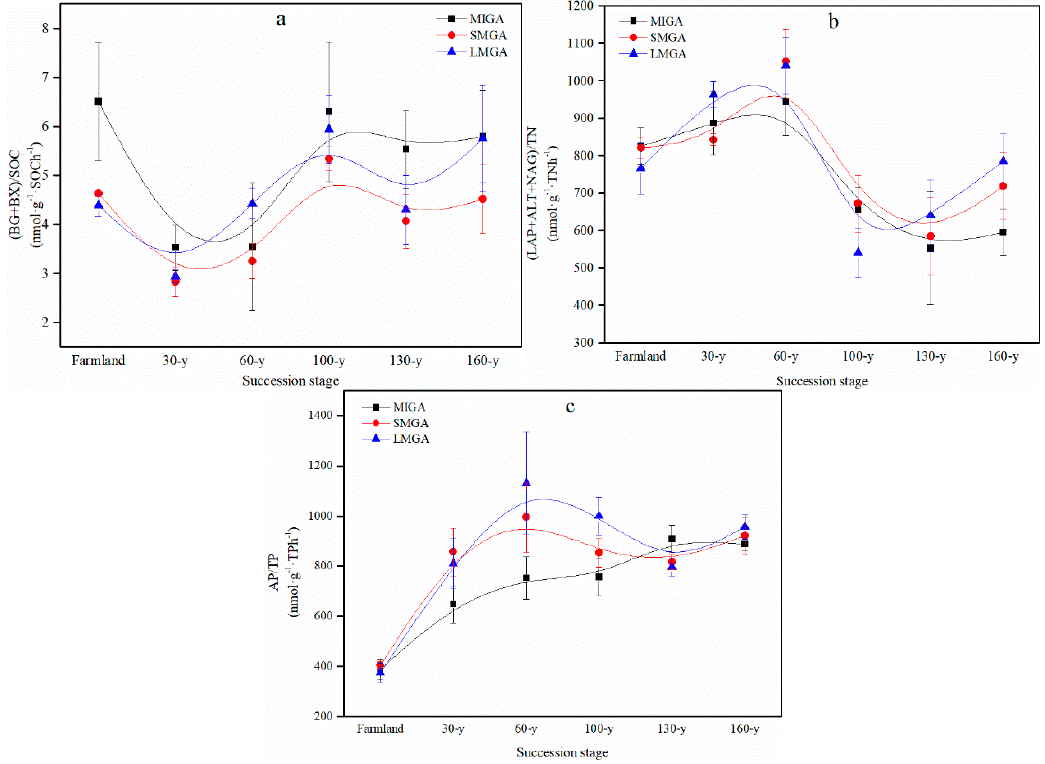
Figure 6. Changes in (BG+BX)/SOC ( a ), (NAG+ LAP+ ALT)/TN ( b ), and AP/TP ( c ) in different sizes of soil aggregates with the vegetation succession. Error bars denote Standard error.